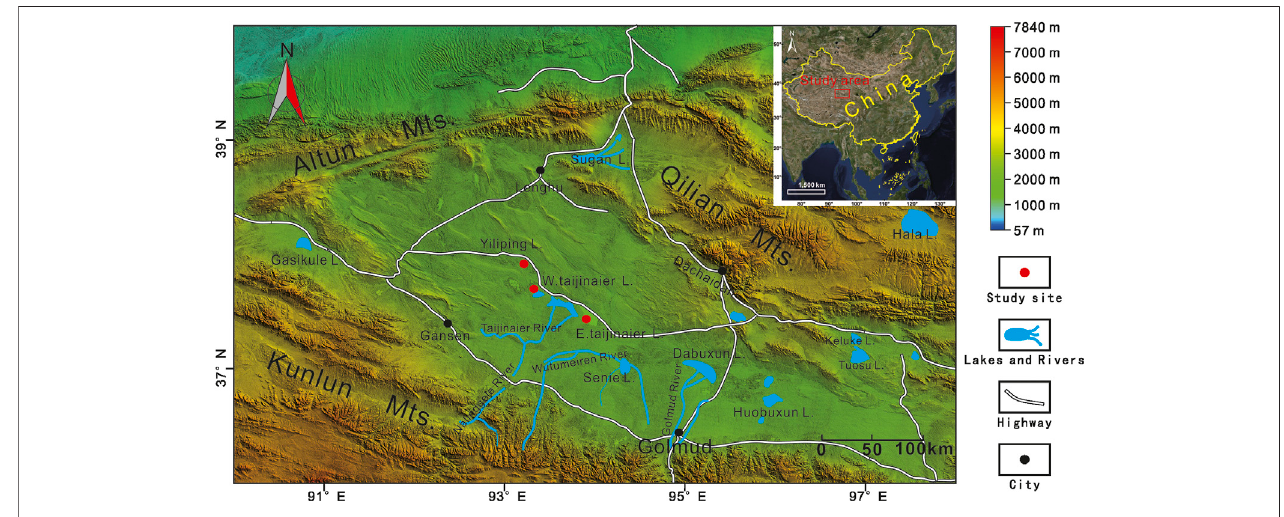
FIGURE 2 | Location of study sites in the western Qaidam Basin (DT, XTW, and YLP sections).